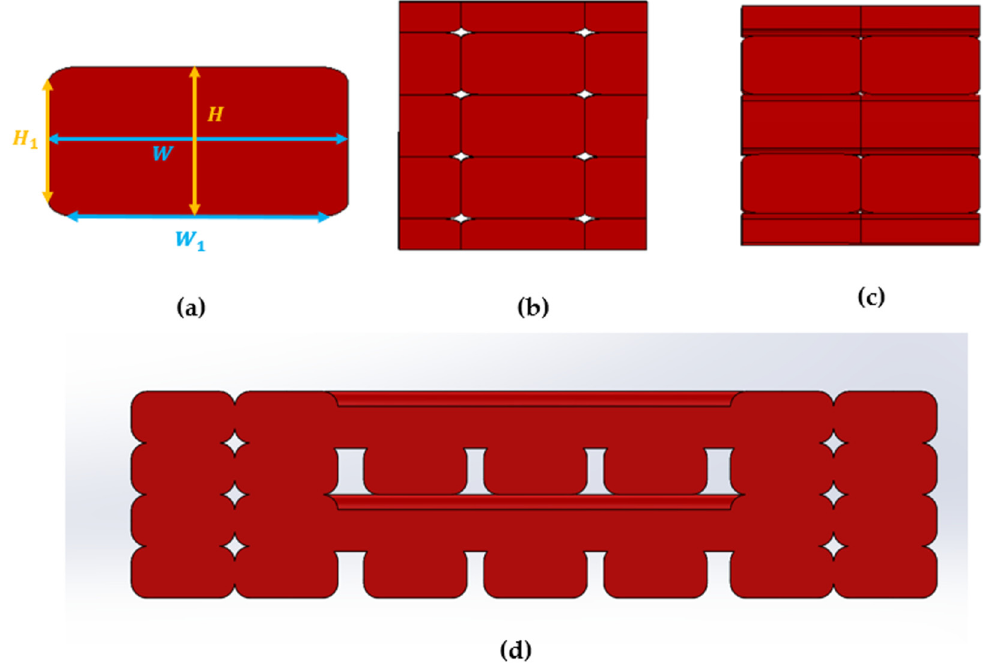
Figure 4. ( a ) Intrinsic element; ( b ) Regions 1 and 3—aligned model; ( c ) Region 2—sparse model; and ( d ) full RVE model.